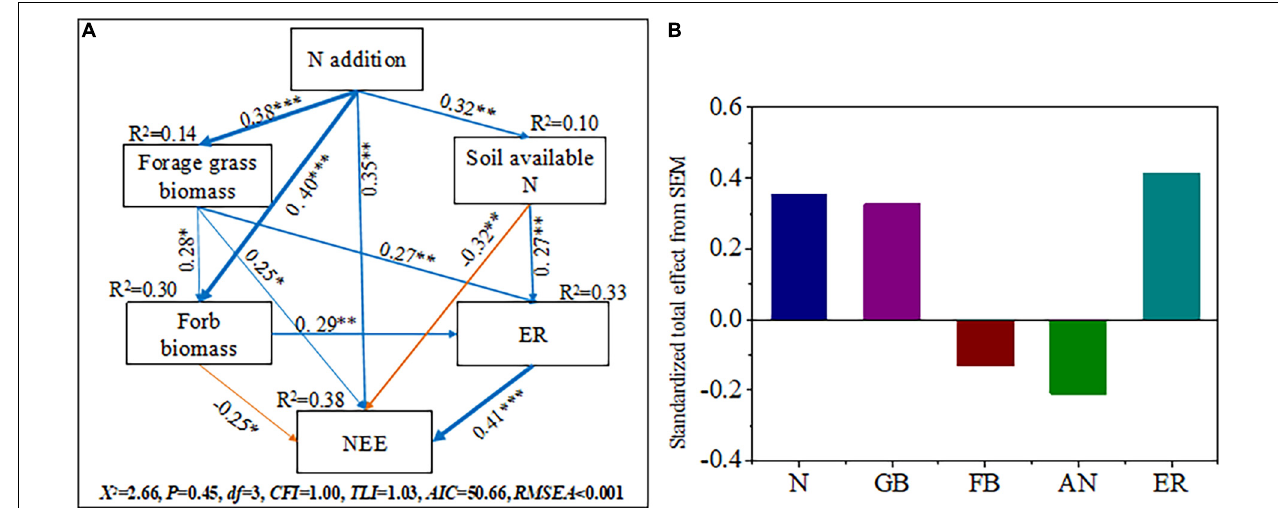
FIGURE 6 | Structural equation models reveal direct and indirect influences of soil available N, forage grass biomass and forb biomass on the CO 2 fluxes (NEE: net ecosystem CO 2 exchange, ER: ecosystem respiration) to N addition (A) and (B) . N, N addition; GB, forage grass biomass; FB, forb biomass; AN, soil available N. Single-arrowed pathways indicate the directional effect between variables. The values associated with pathways are the standardized path coefficients. The R 2 -values are given for soil available N, forage grass biomass, forb biomass, ER, and NEE, indicating the variance explained by the model ( R 2 ). The fitness statistics, Chi-squared ( χ 2 ), degrees of freedom ( df ), P-value and root mean square error of approximation (RMSER), Tucker–Lewis index (TLI), comparative fit index (CFI) are given for the fitness of the model. The χ 2 -test with p > 0.05 and the RMSER ≤ 0.05 indicates that the model is acceptable. The width of the arrows indicates the strength of the relationships. Blue arrows indicate significant positive relationships and orange arrows indicate significant negative relationships. The numbers on the line indicate standardized path coefficients. Stars indicate significant correlations. * p < 0.05, ** p < 0.01, *** P < 0.001. The data shown here include all data collected across the treatments and years. See Supplementary Figure 4 and Supplementary Table 4 for more details of the a priori model.